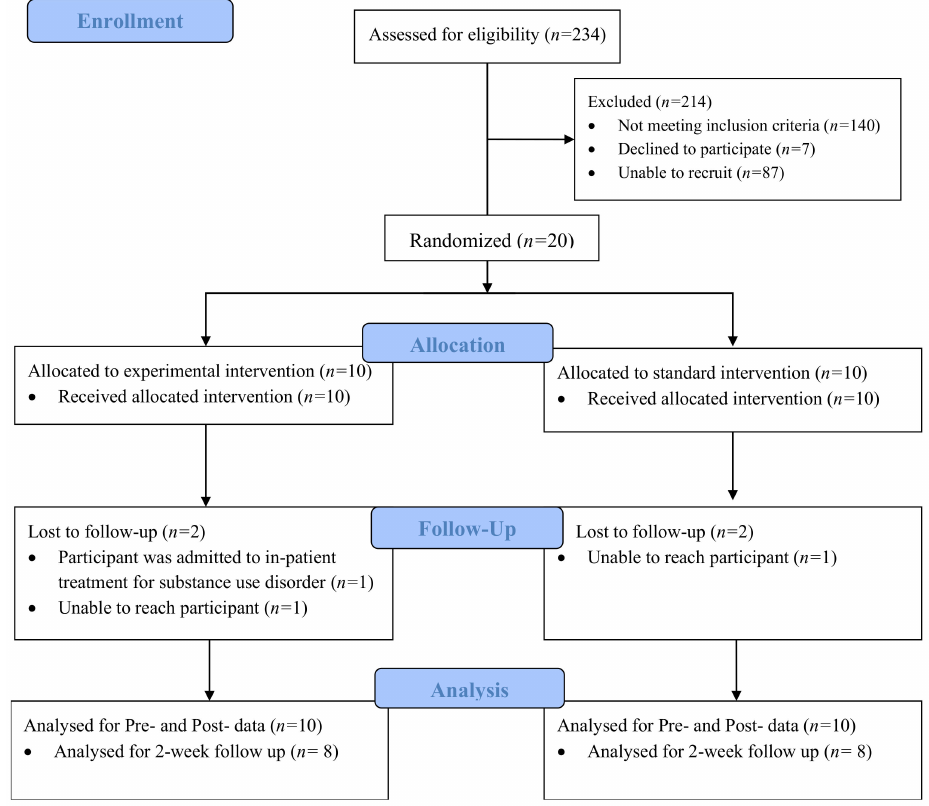
Figure 1. CONSORT Flow Diagram of Study